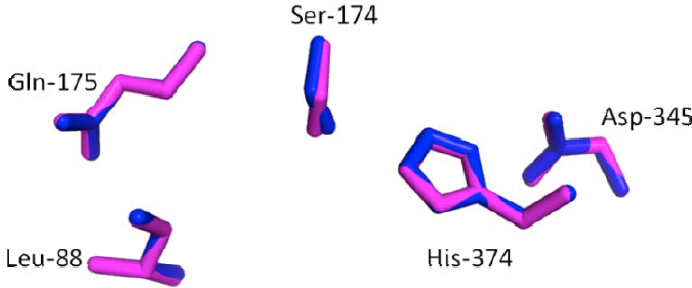
(blue) and dGL (magenta color) are superimposed. The residues are numbered according